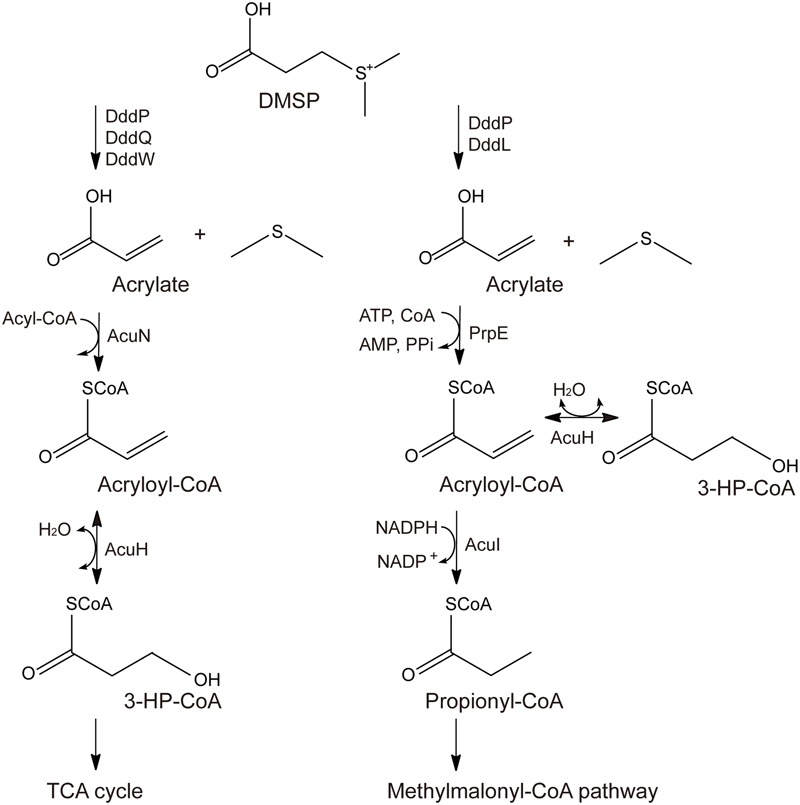
Proposed metabolic pathways for acrylate detoxification. The left is the AcuN-AcuK pathway in Halomonas sp. HTNK1 (Curson et al., 2011; Reisch et al., 2013), and the right is the PrpE-AcuI pathway in Ruegeria pomeroyi DSS-3 (Curson et al., 2011; Reisch et al., 2013).